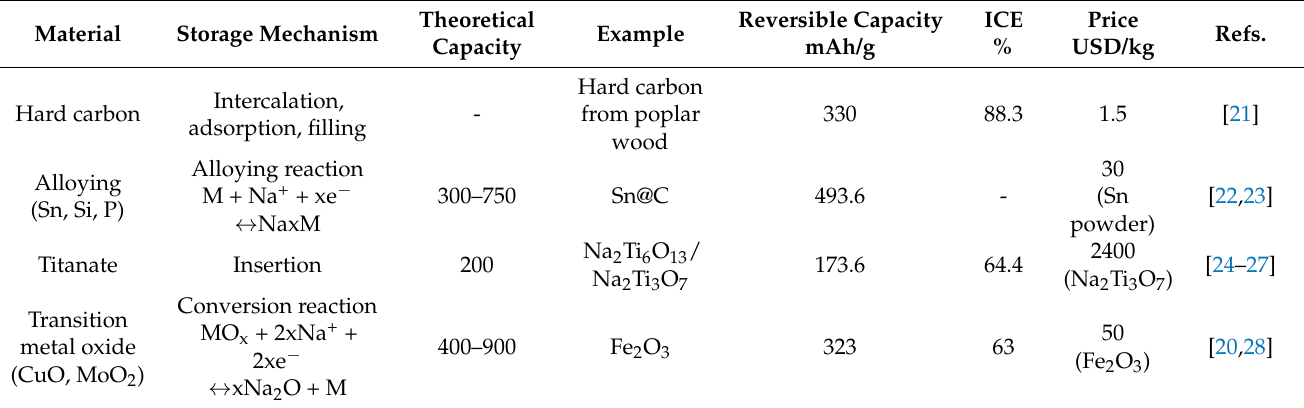
Table 2. Suitable anode materials in